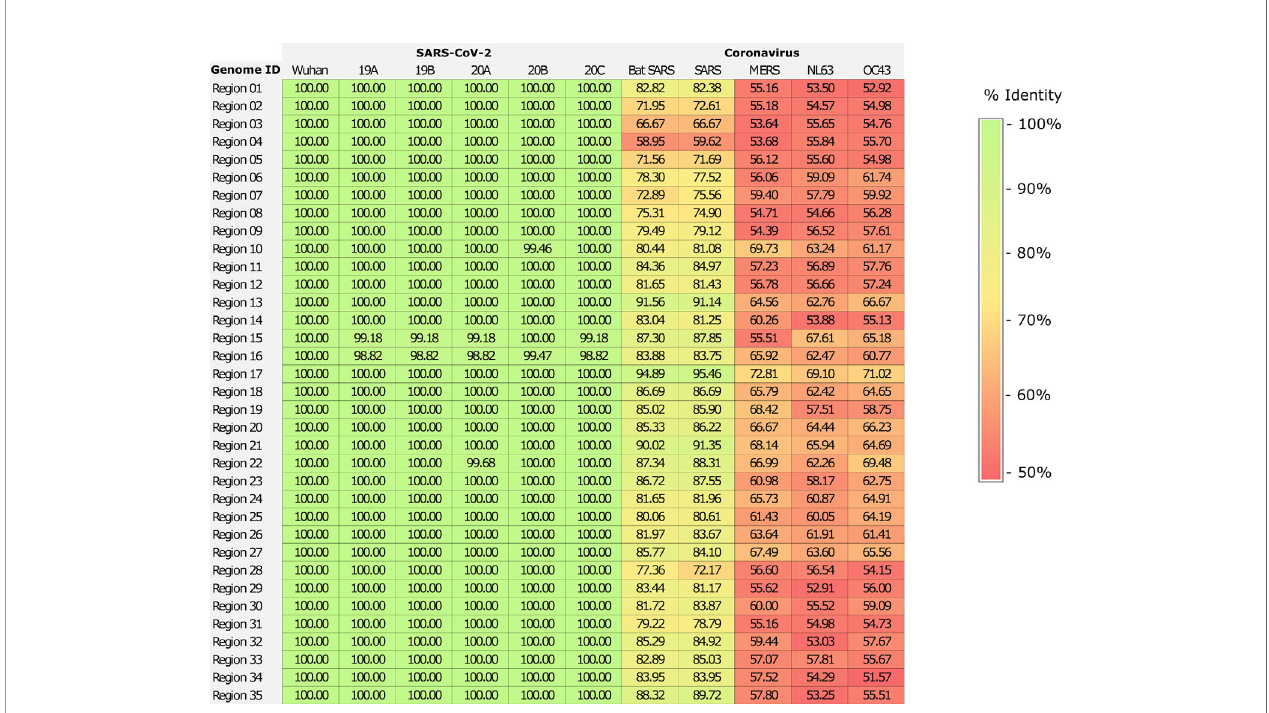
FIGURE 2 | Similarity matrix of conserved region alignments involving SARS-CoV-2 genomes and other coronavirus sequences. The alignment included SARS-CoV- 2 genomes from Wuhan (EPI_ISL_402124) and of fi ve genetic clades circulating in Peru (19A [MW030214], 19B [MW030206], 20A [MW030246], 20B [MW030232] and 20C [MW030200]), and genomes of closely related viruses, comprising SARS-CoV (DQ898174), human coronavirus (NC_005831 and JN129835), MERS-CoV (KF192507), and bat coronavirus